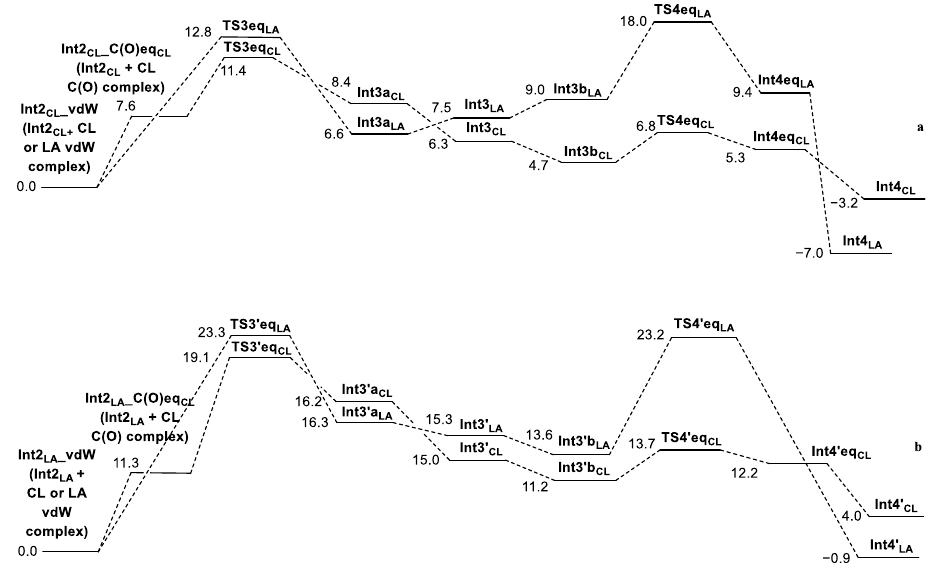
Figure 3. The Gibbs free energy profiles of propagation steps with equatorial CL or LA addition to Int2 CL ( a ) and Int2 LA ( b ).